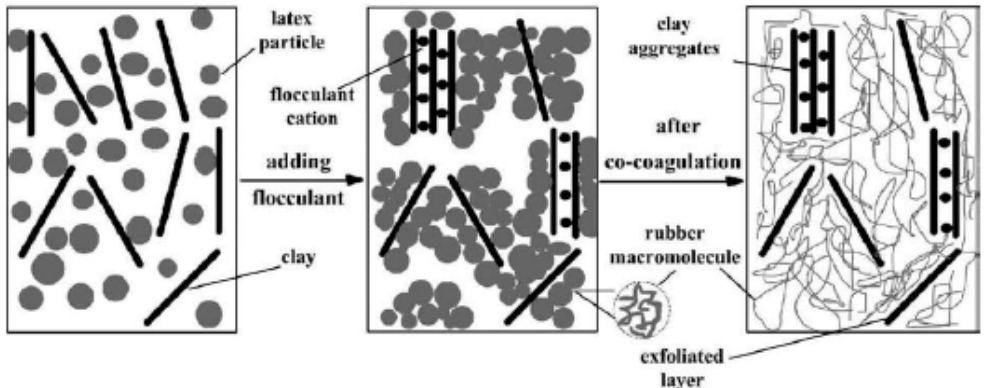
Figure 5. Schematic illustration of the mixing and co-coagulating process. Reproduced with permission from [46]. Copyright Elsevier, 2005.